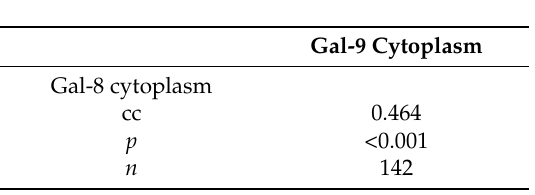
Table 3. Correlation